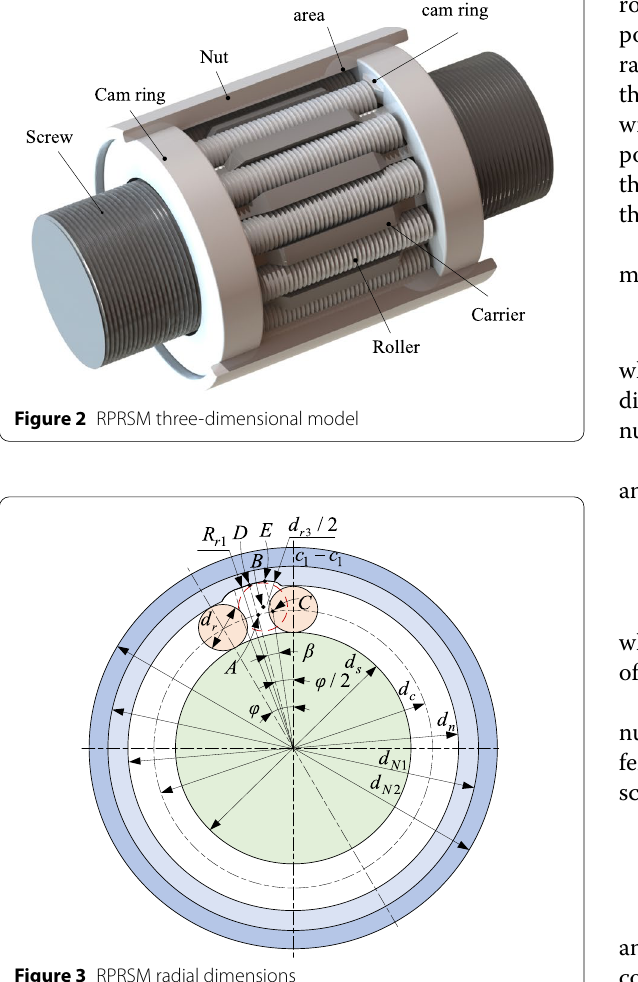
Figure 3 RPRSM radial